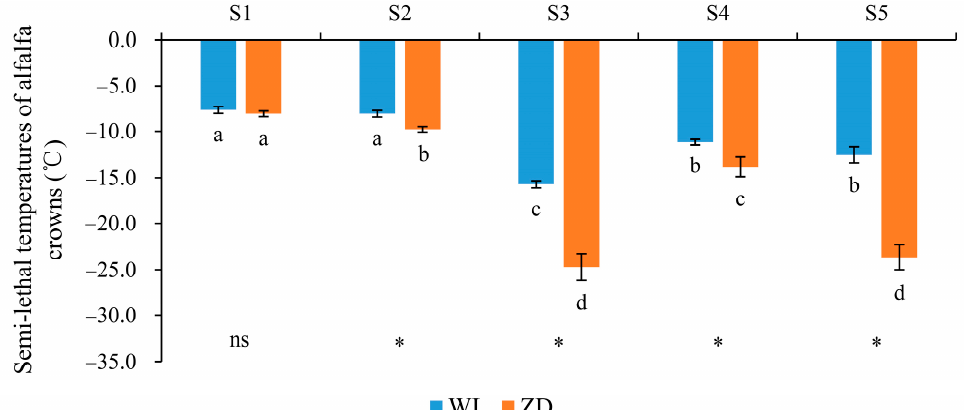
Figure 2. Semi-lethal temperature (LT 50 ) of alfalfa crowns at five sampling points. Mean values ( n = 5) ± standard errors of the mean are shown. Different letters (a, b, etc.) below bars indicate a significant difference among the five sampling points (from S1 to S5) in one cultivar ( p < 0.05). The asterisk indicates a significant difference between the cultivars (S1 vs. S1, S2 vs. S2, etc.) at one same sampling point ( p < 0.05), and the ‘ns’ indicates no significant difference. S1 to S5 are the sampling points after the five phases of the temperature-controlled treatment regime: in phase 1 the temperature was maintained at 18 °C, in phase 2 it decreased to 2 °C, in phase 3 it was maintained at 2 °C and − 2 °C for two weeks, in phase 4 it increased to 18 °C, and in phase 5 it decreased to 2 °C. WL = WL440HQ, ZD = ZhaoDong.